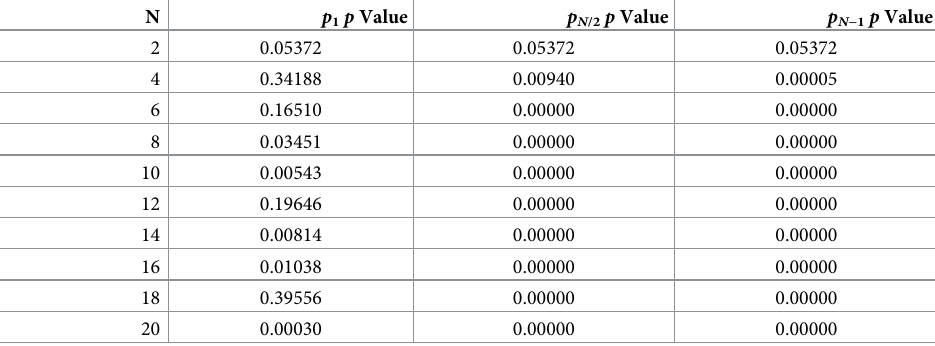
Table 3. p − values resulting from a t − test comparing the theoretic value with the simulated value of the Moran process fixation probabilities for stochastic strategies: Calculator and Arrogant Q Learner. N p 1 p Value p N /2 p